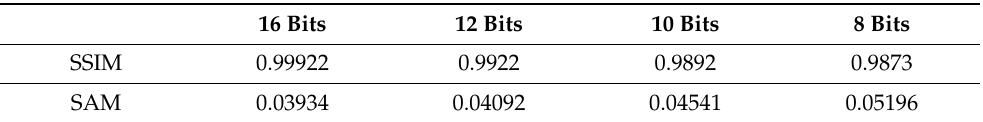
Figure 11. Quantization noise effect on SpLM with 4 mFPR stairs, 16 bits, 12 bits, 10 bits, and 8 bits, on 2 examples of spectra reconstruction. Table 4. The metrics of SSIM and SAM on the test set for quantization noise of 4 measurements with 16 bits, 12 bits, 10 bits, and 8 bits.